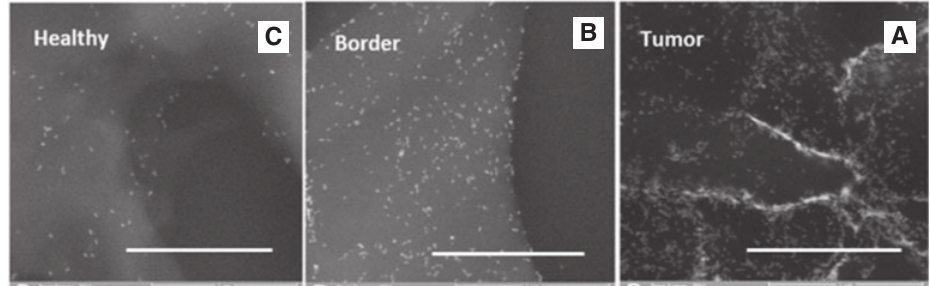
Figure 4: GNRs attachment to squamous cell carcinoma. The tumor slide images captured by the airSEM at tumor (A) border (B) and normal (C)